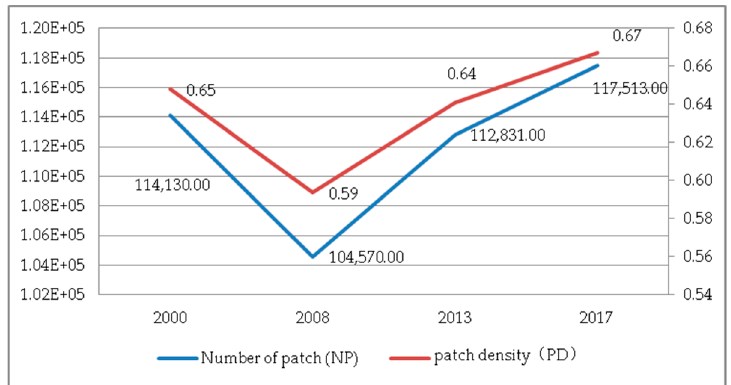
Figure 11. The NP and PD at the landscape level.